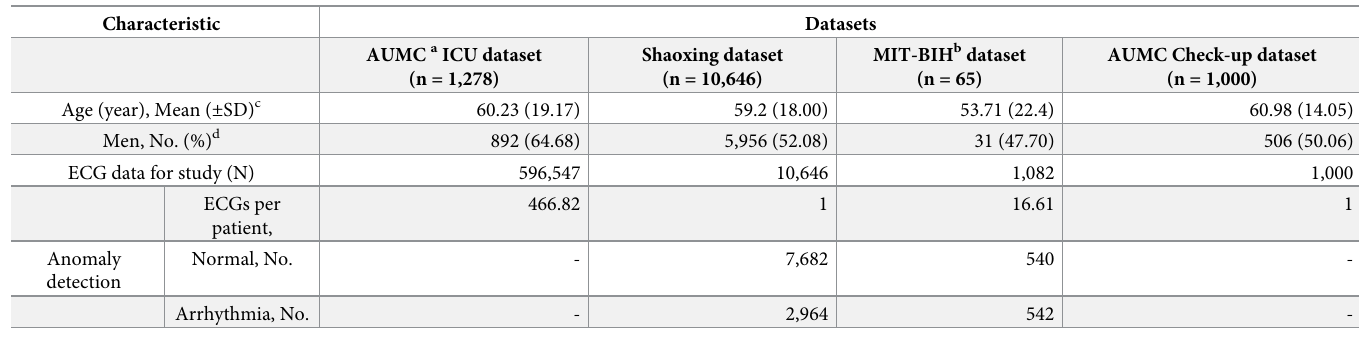
Table 1. Baseline characteristics of each